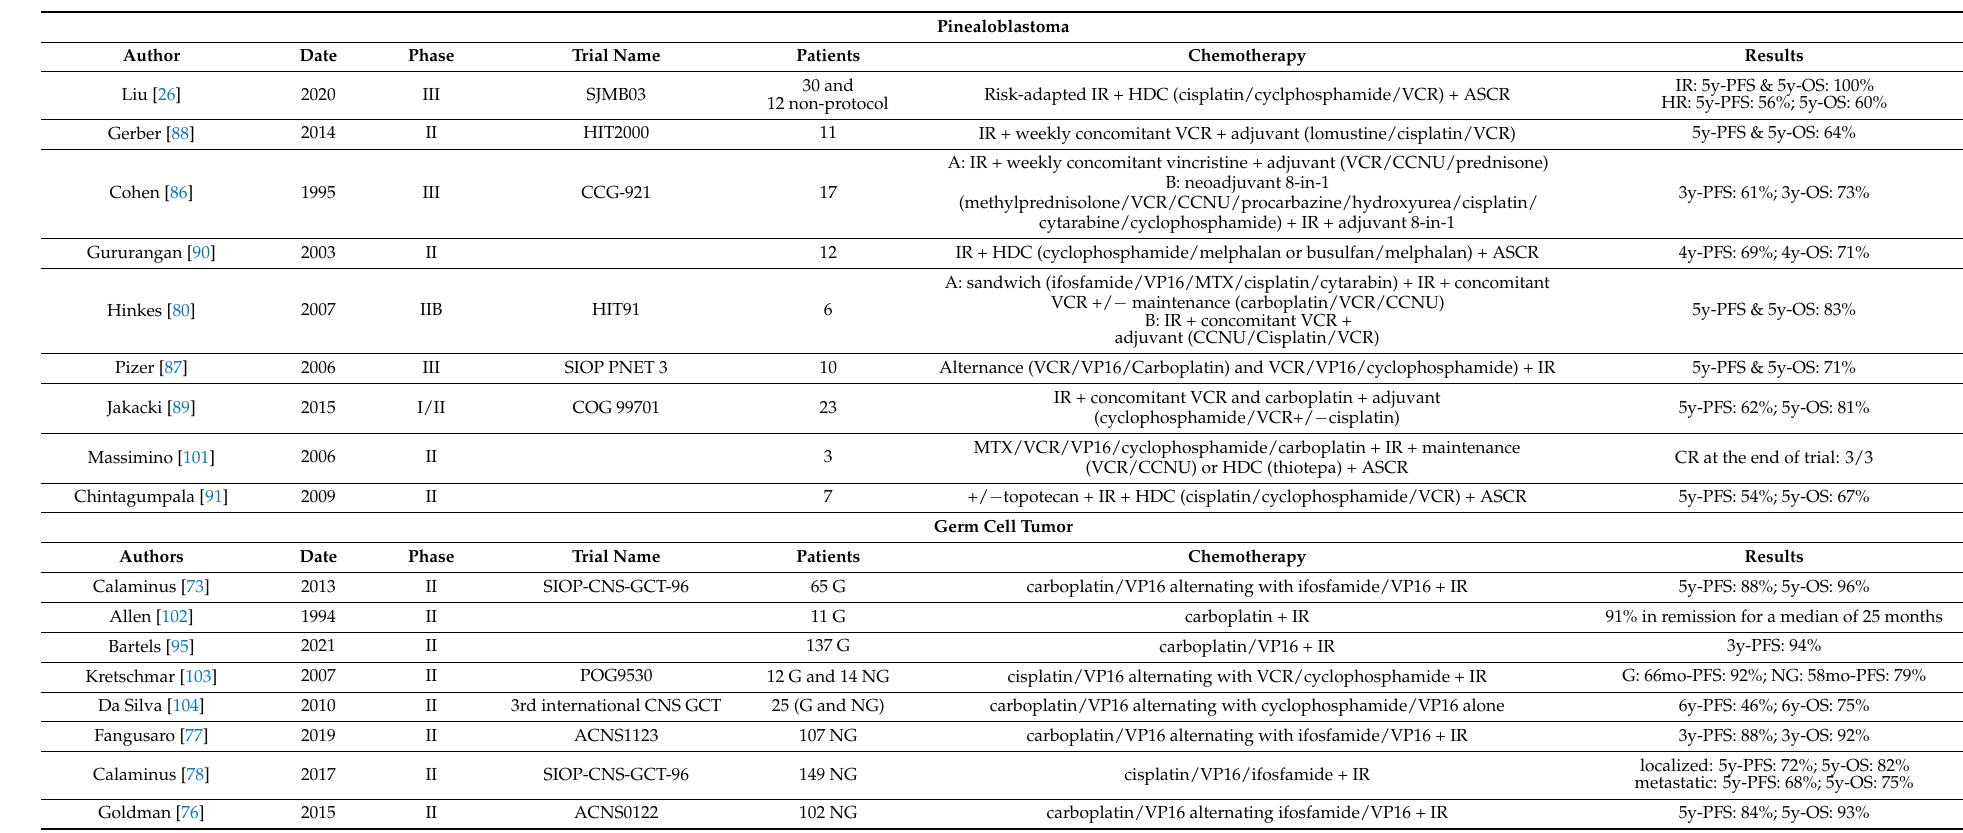
Table 4. Clinical trial